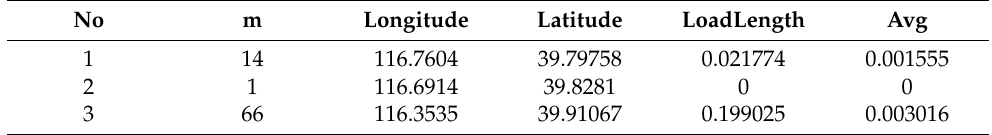
Table 10. The clustering results of PS_DBSCAN for the DS1 dataset.